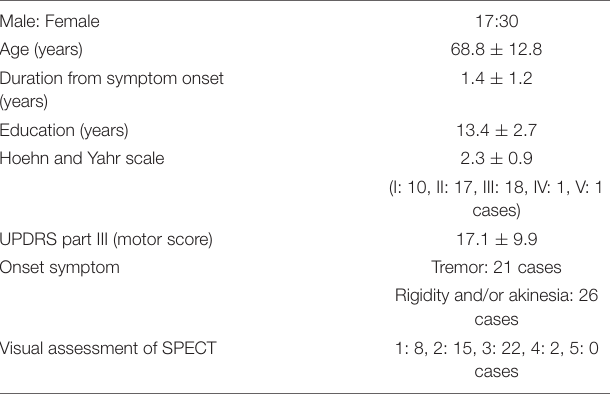
TABLE 2 | Patient background.